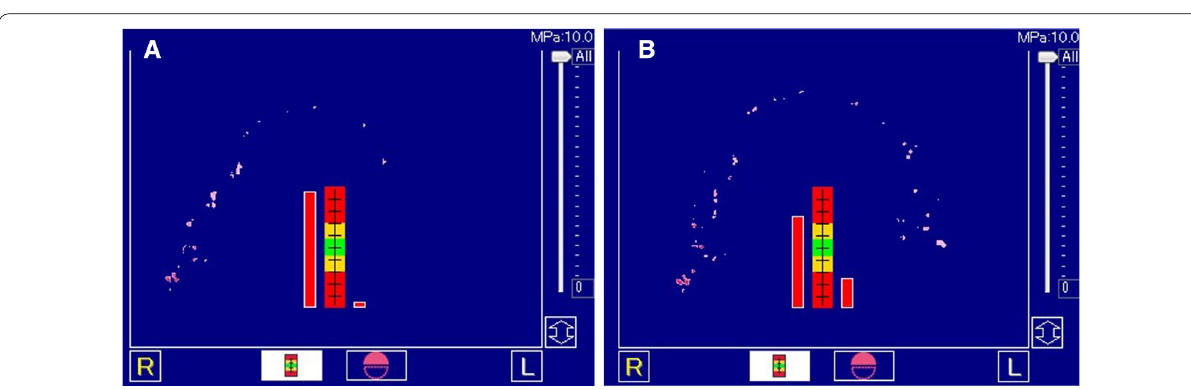
Fig. 11 Maximum bite force examination before ( a ) and after ( b ) prosthetic